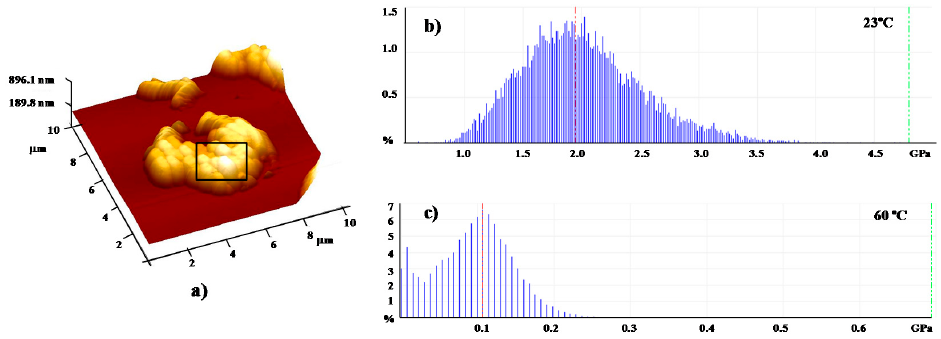
Figure 1. Results for PMMA:tetracosane (1:3): ( a ) 3D image tested; ( b ) Effective Young’s modulus results at 23 °C; ( c ) Effective Young’s modulus results at 60 °C.